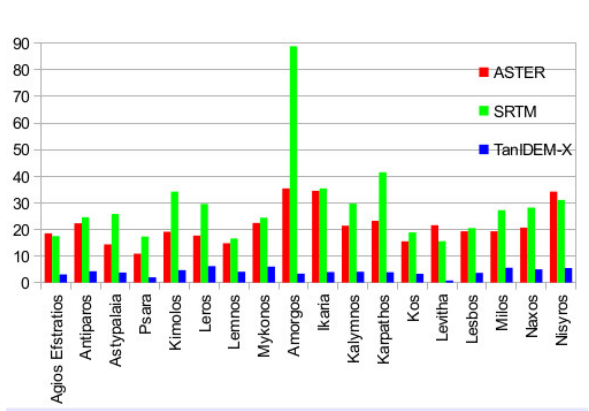
Figure 9. RMSE (m) of the global DEMs with respect to local elevation data. (DX,DY,DZ)=(0,0,0).